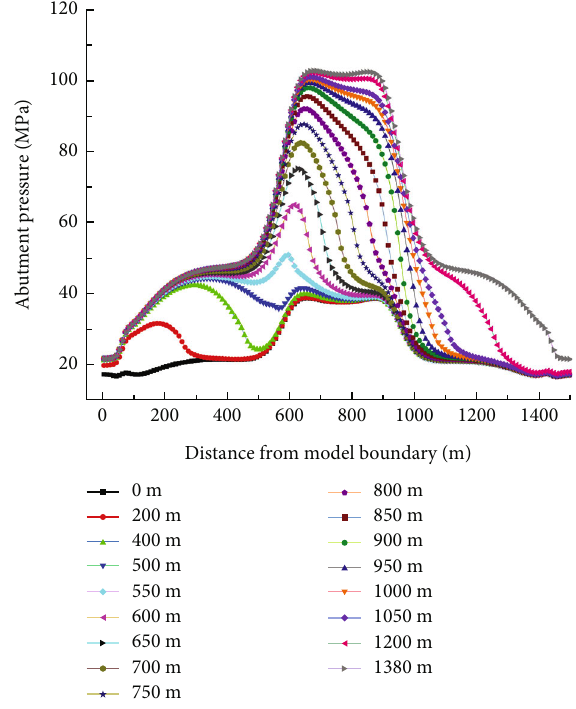
Figure 8: Abutment pressure in the section coal